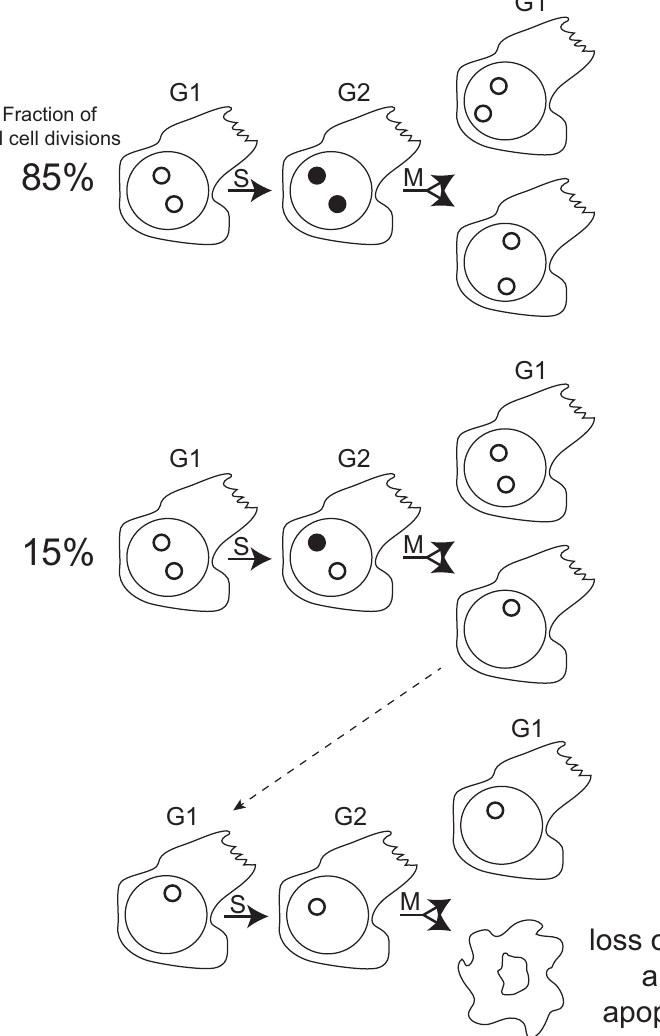
Figure 2. Defects in the synthesis of EBV DNA lead to its loss in proliferating cells. Shown diagrammatically are lymphoid cells with two molecules of EBV DNA (open circles) present in the cells on the left in the G1 phase of the cell cycle. During S phase, , 85% of the viral DNAs are synthesized and remain localized together (black circles); 15% of the viral DNAs fail to be synthesized (open circle). The newly synthesized viral DNAs are segregated during M phase to the daughter cells faithfully 88% of the time as shown in the pairs of daughters on the right. The defects in viral DNA synthesis lead to some daughter cells having fewer viral DNA molecules than did their parents and inevitably to some daughter cells having none as shown for the progeny at the bottom of the figure. Cells dependent on EBV for survival functions as found for EBV-positive lymphomas will die by apoptosis on losing the viral genome.